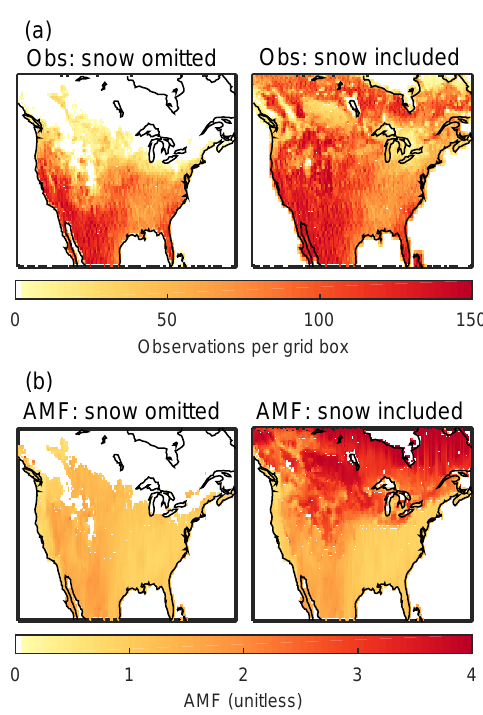
Figure 6. OMI observation frequency (a) and average AMFs (b) over North America in January using IMS to identify surface snow conditions. White space indicates a lack of